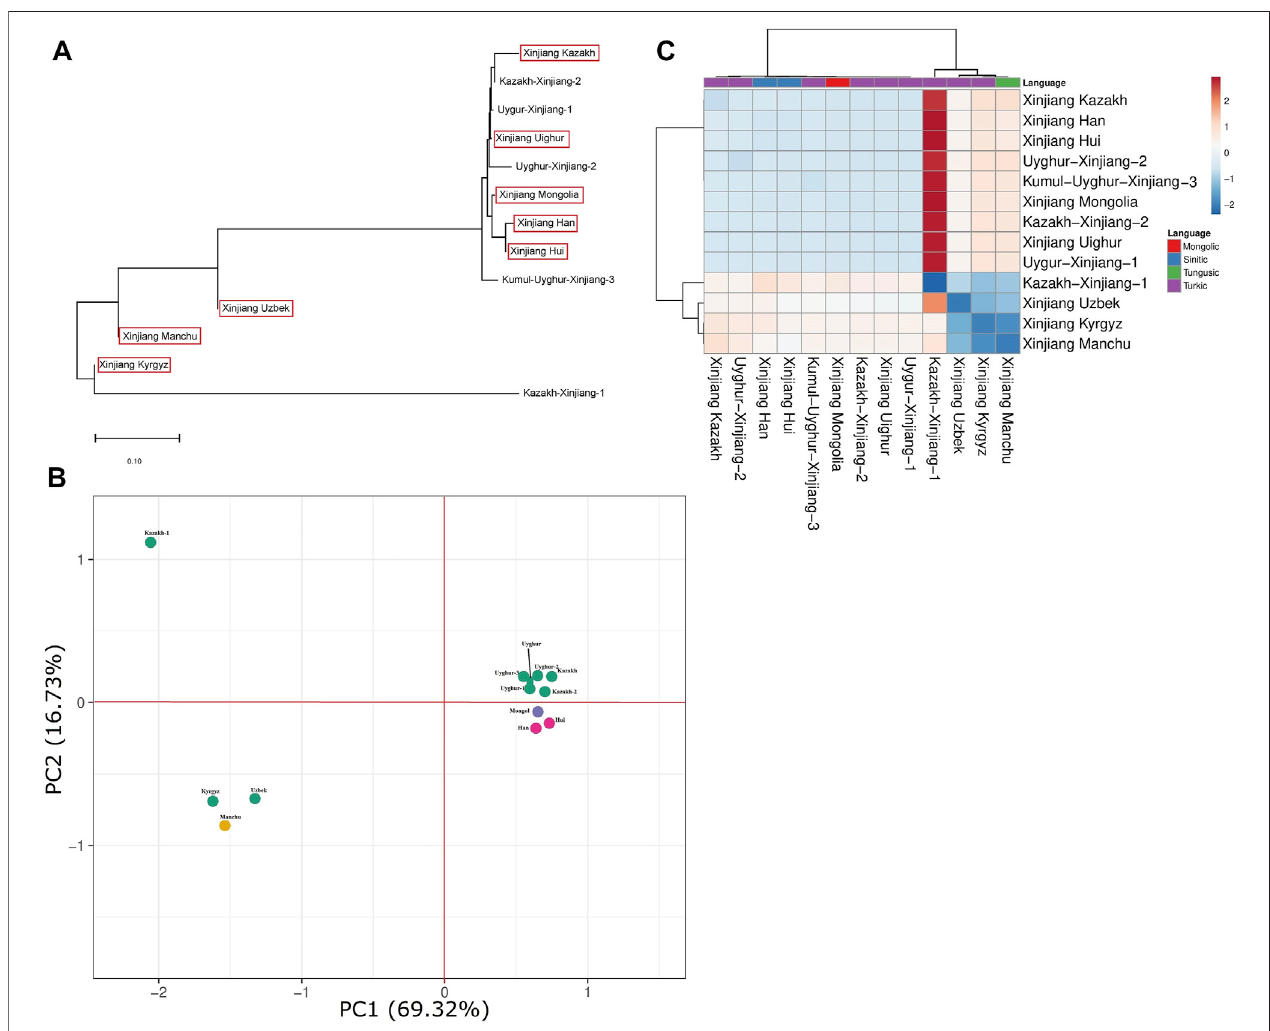
FIGURE 3 | (A) A Neighbor-joining tree explaining the phylogenetic relationship between Xinjiang populations. (B) A heat map of pairwise Nei ’ s genetic distance values between Xinjiang populations. (C) Principal component analysis (PCA) based on Nei ’ s genetic distance revealed by the fi rst two components between Xinjiang